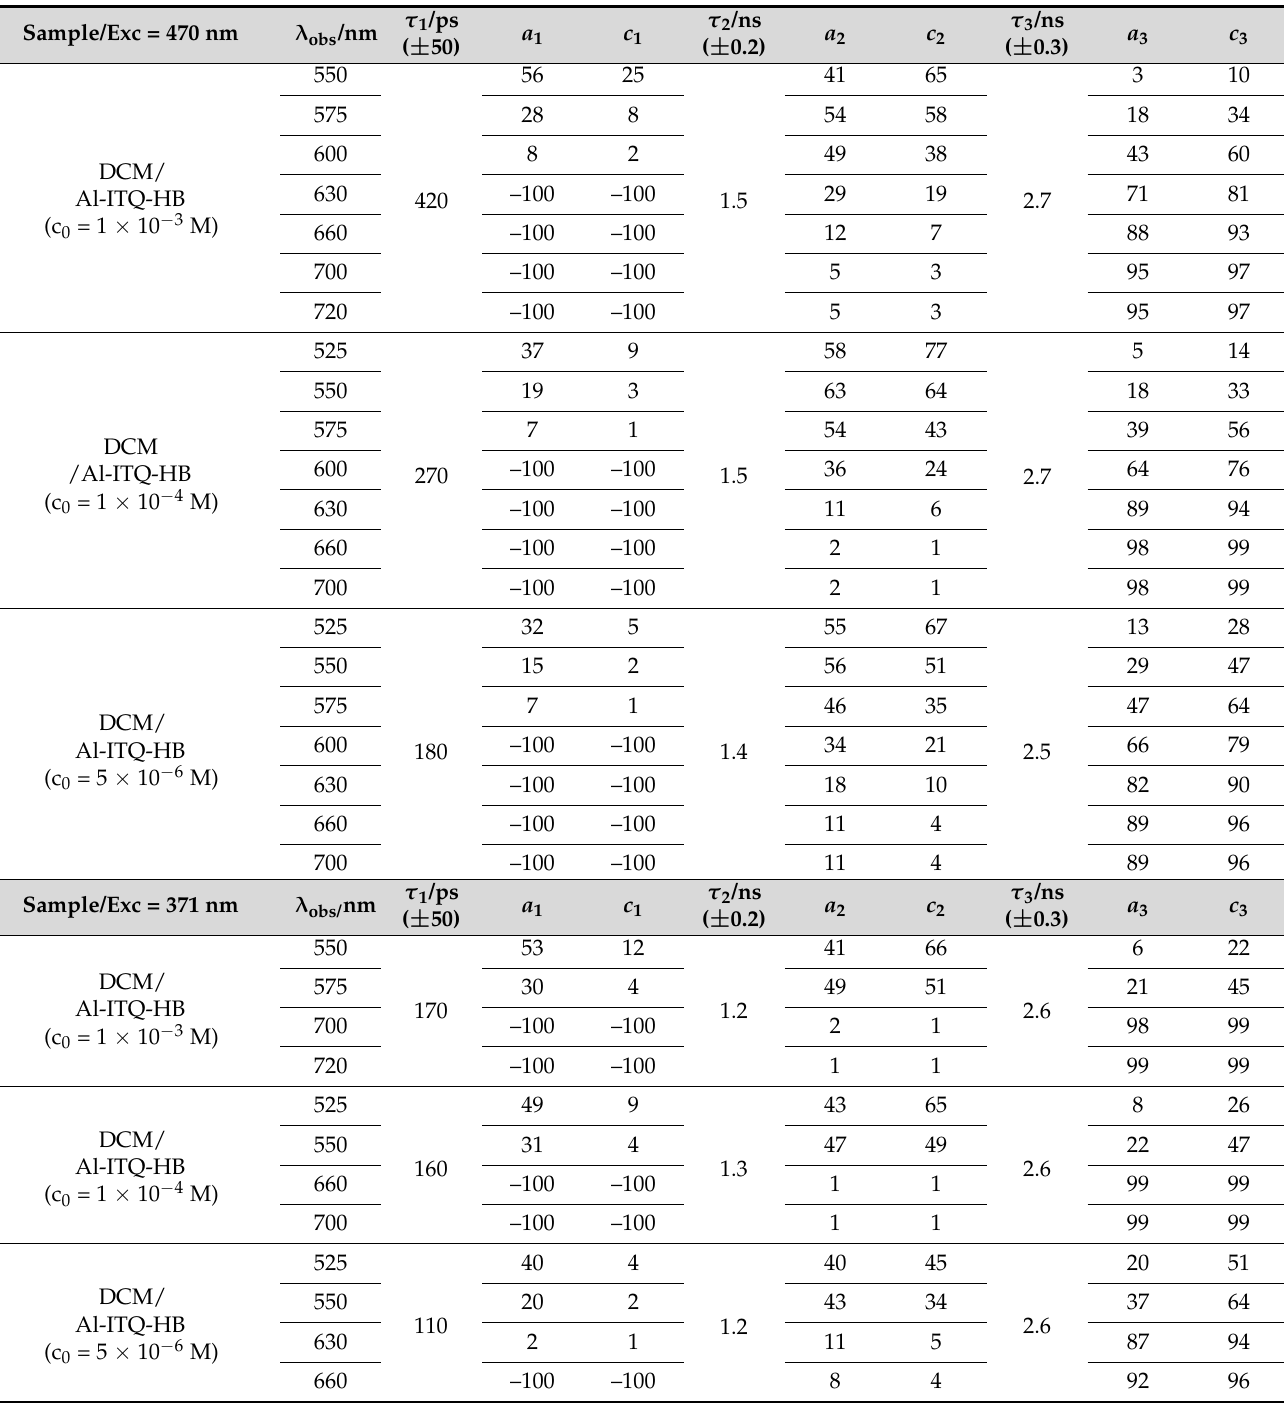
Table. The estimated uncertainty of the time constants, considering the errors from the experiments as well as those arising from the multi-exponential fit of the signals, was between 15 and